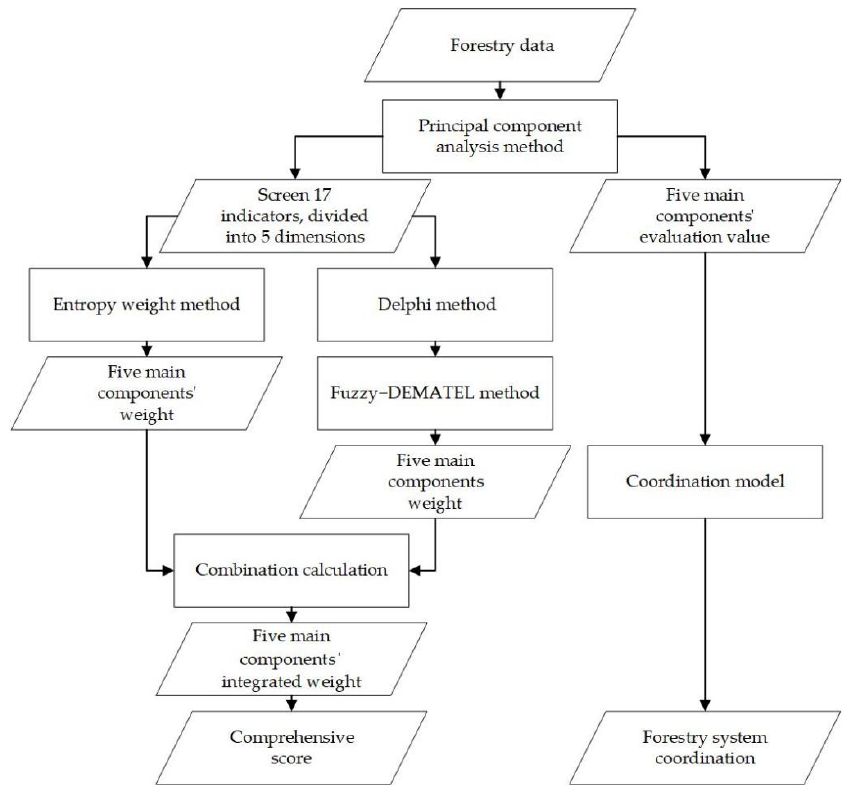
Figure 3. Flowchart of the proposed hybrid ensemble evaluation approach.